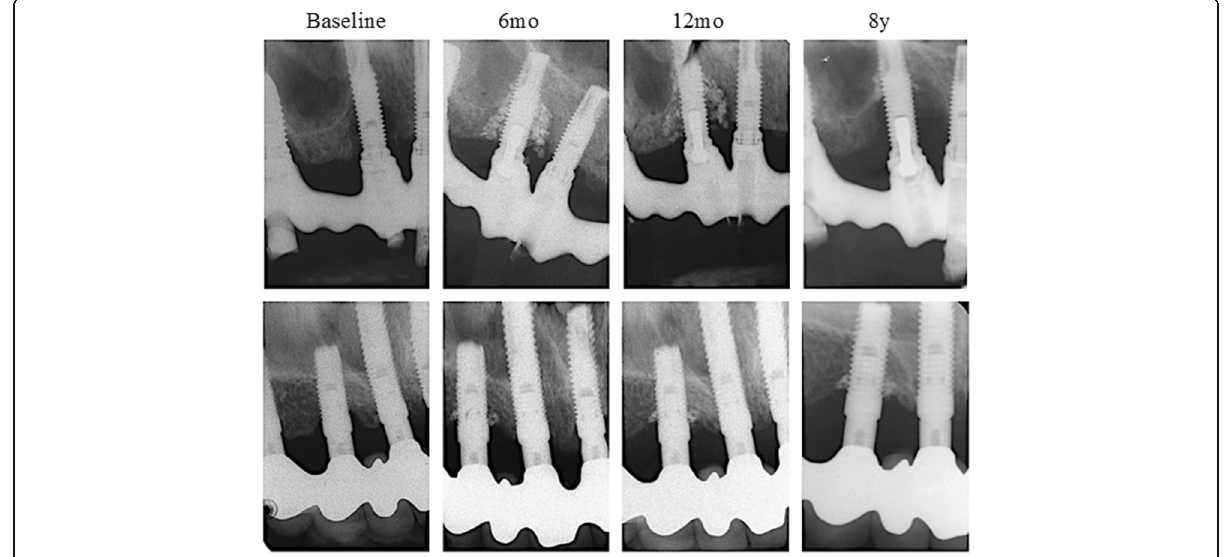
Fig. 2 PTG observed in radiographs at the 8-year